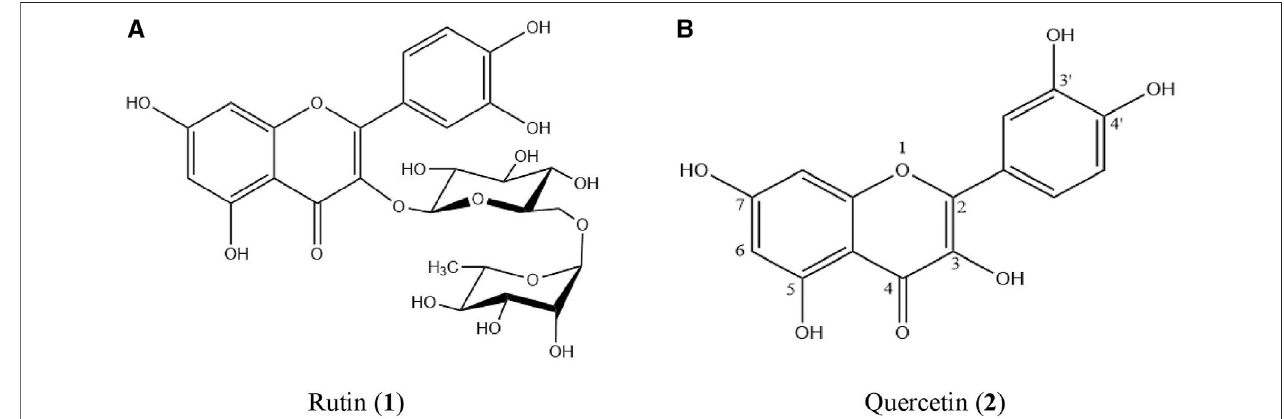
FIGURE 3 | The structure of (A) rutin ( 1 ) and (B) quercetin ( 2 ).